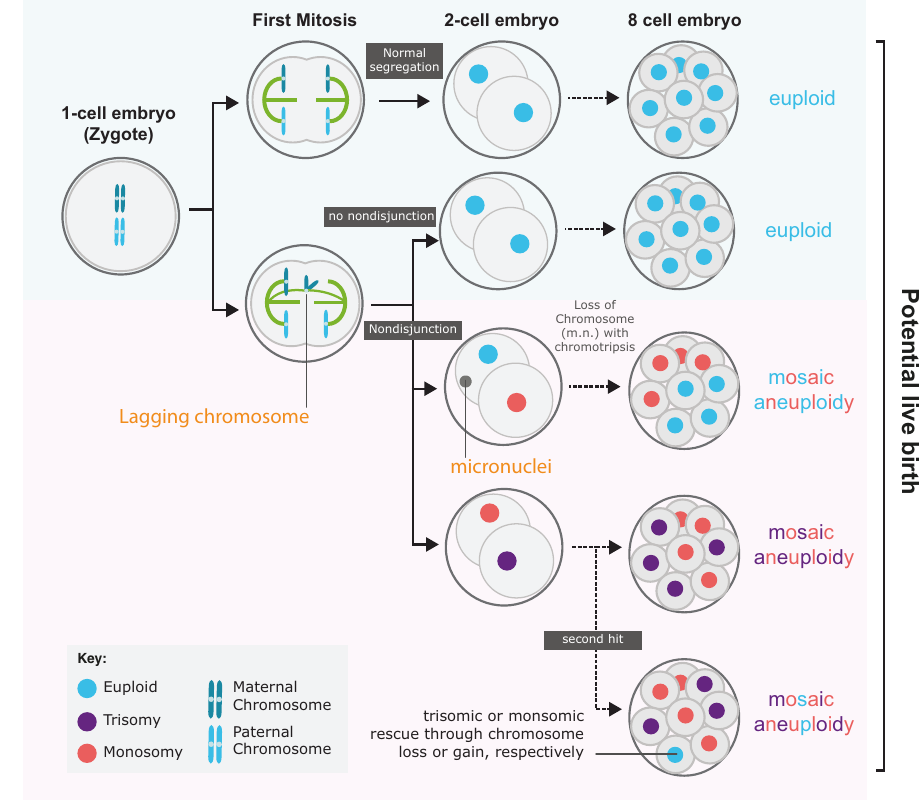
Fig. 7 | Model of how fi rst division errors can lead to different euploid/aneu- ploid embryos. Top row, a pair of homologous chromosomes (blue) are correctly segregated into the 2-cell embryo. Subsequent divisions (dotted black arrow), if occurringwithouterror,wouldleadtoan8-cellembryoinwhichallblastomeresare euploid(blue).Secondrow;Non-disjunctionduringthe fi rstmitosiswouldresultin trisomic and monosomic blastomeres (purple and red) with two potential out- comes: upper — lagging chromosome becomes a micronucleus (m.m.) that